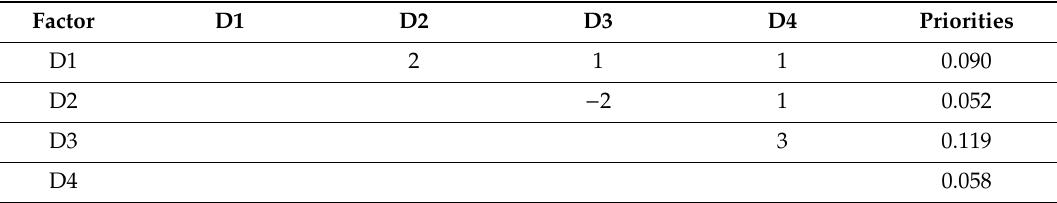
Table 8. Compare the relative importance with respect to infrastructural criterion